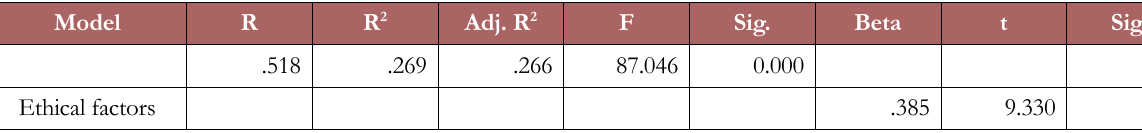
Table 6. Linear regression model for ethical factors- implementation of 5S and